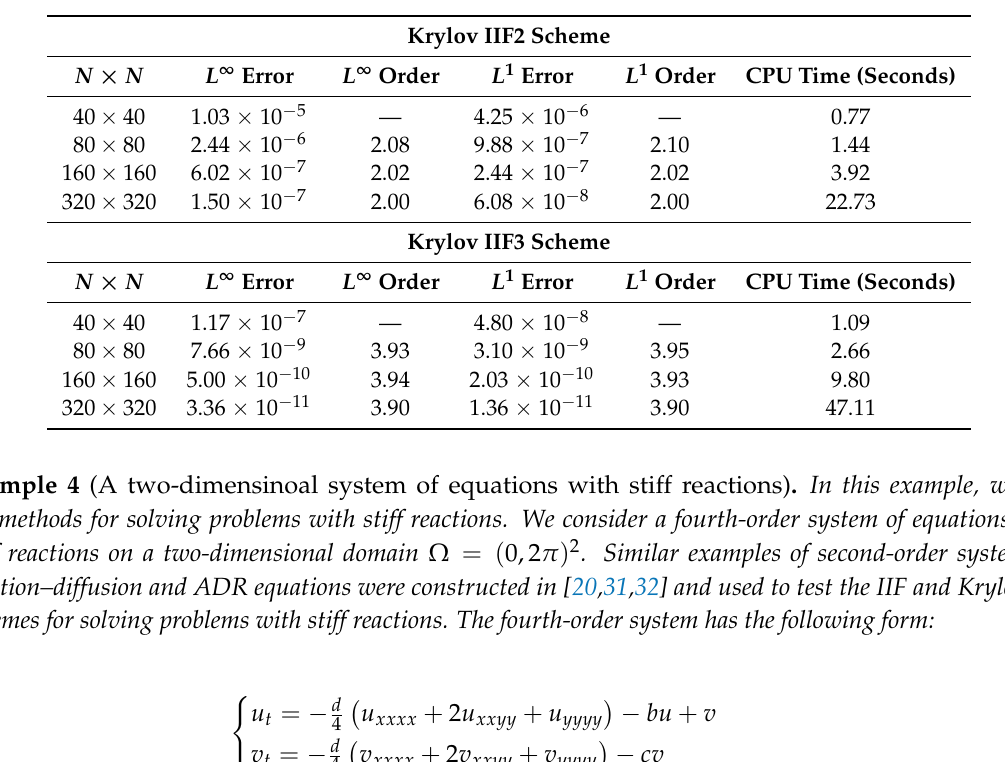
Table 3. Example 3, a two-dimensional scalar problem. CPU time, numerical errors and orders of accuracy of the Krylov IIF2 and Krylov IIF3 schemes. Krylov subspace dimension: M = 5; ∆ t = 0.5 ∆ x ; final time T =